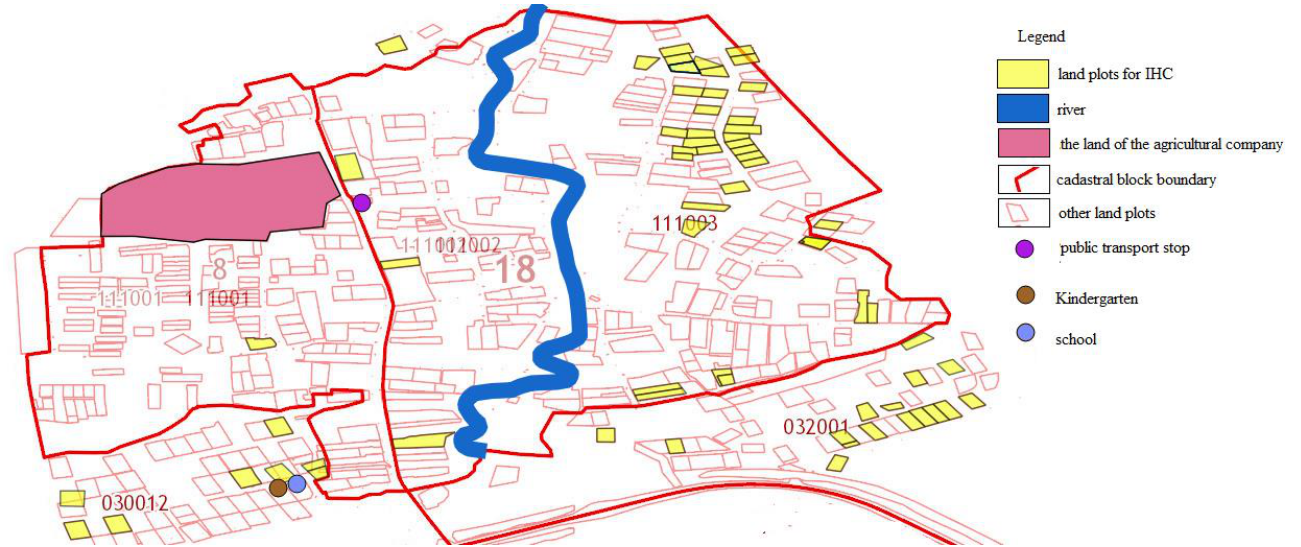
Figure 3. Thematic map of Novaya Kazmaska village. Source: Own study.